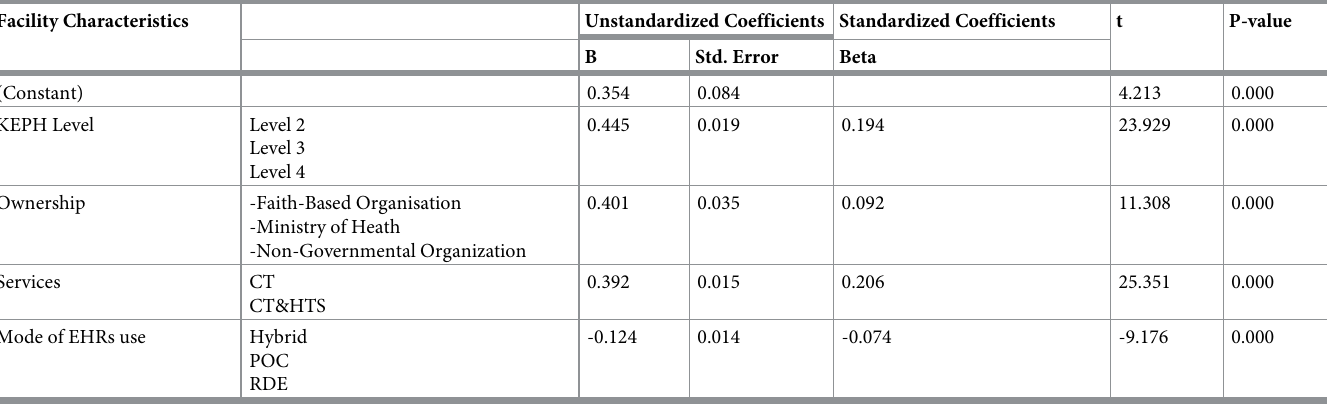
Table 3. Multiple linear regression model for staff system use and facility